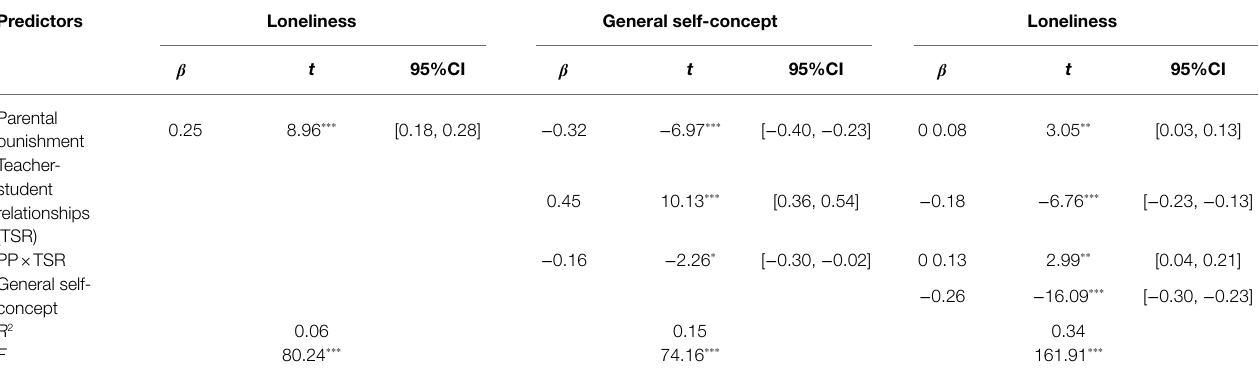
TABLE 2 | The moderated mediation effect test of parental punishment (PP) on loneliness ( n = 1, 169). Predictors Loneliness General self-concept